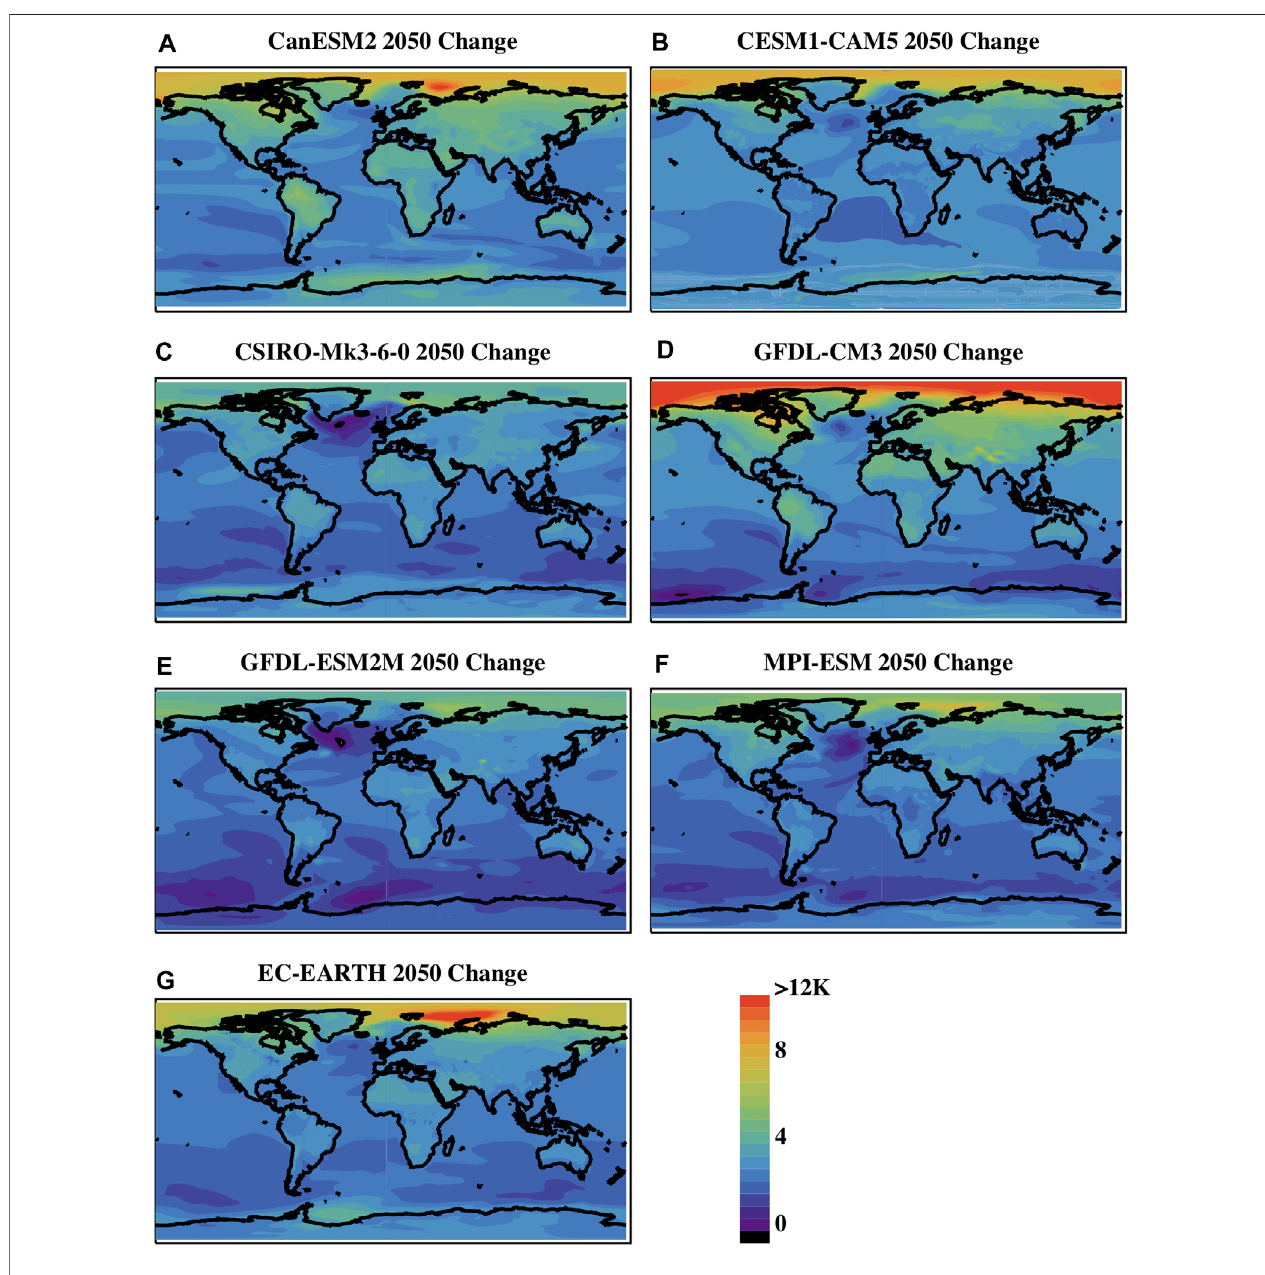
FIGURE 1 | The annual ensemble mean surface air temperature change for the 2050s relative to the reference period for different SMILEs including (A) CanESM2, (B) CESM1-CAM5, (C) CSIRO-Mk-3-6-0, (D) GFDL-CM3, (E) GFDL-ESM2M, (F) MPI-ESM, and (G) EC-EARTH.